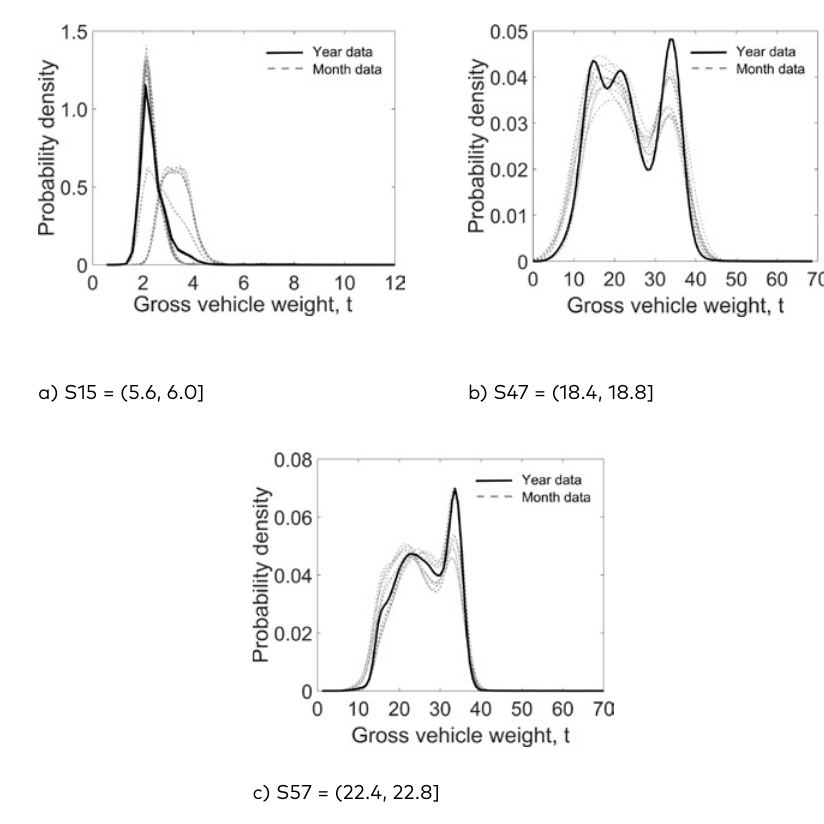
Figure 5. Probability density functions for Weigh-in-Motion